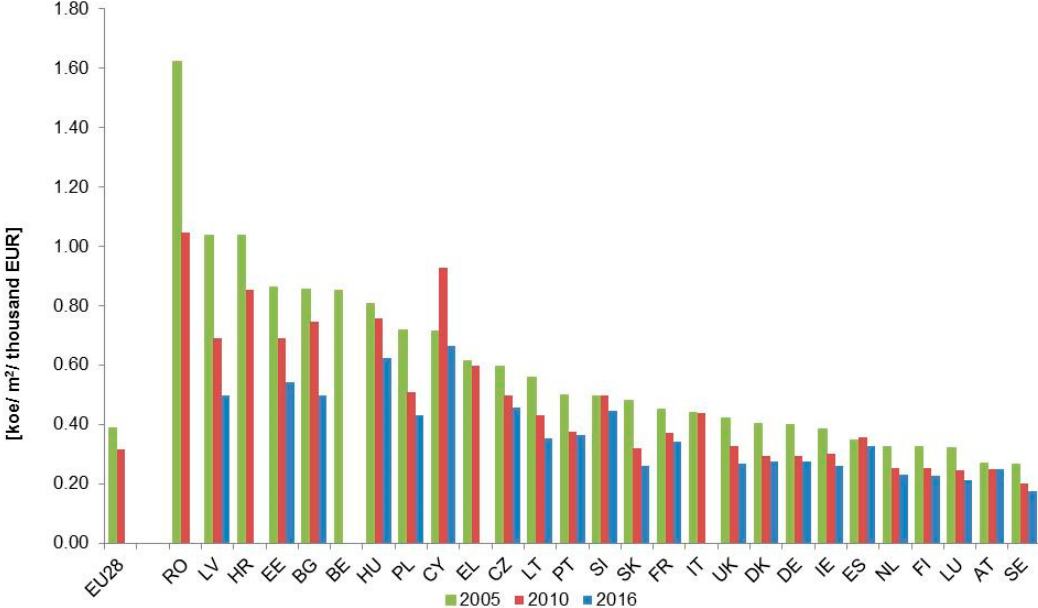
Figure 19. Climate normalised specific residential FEC per adjusted gross disposable income in EU-28 member states, comparison of 2005, 2010, and 2016. Source: Eurostat,